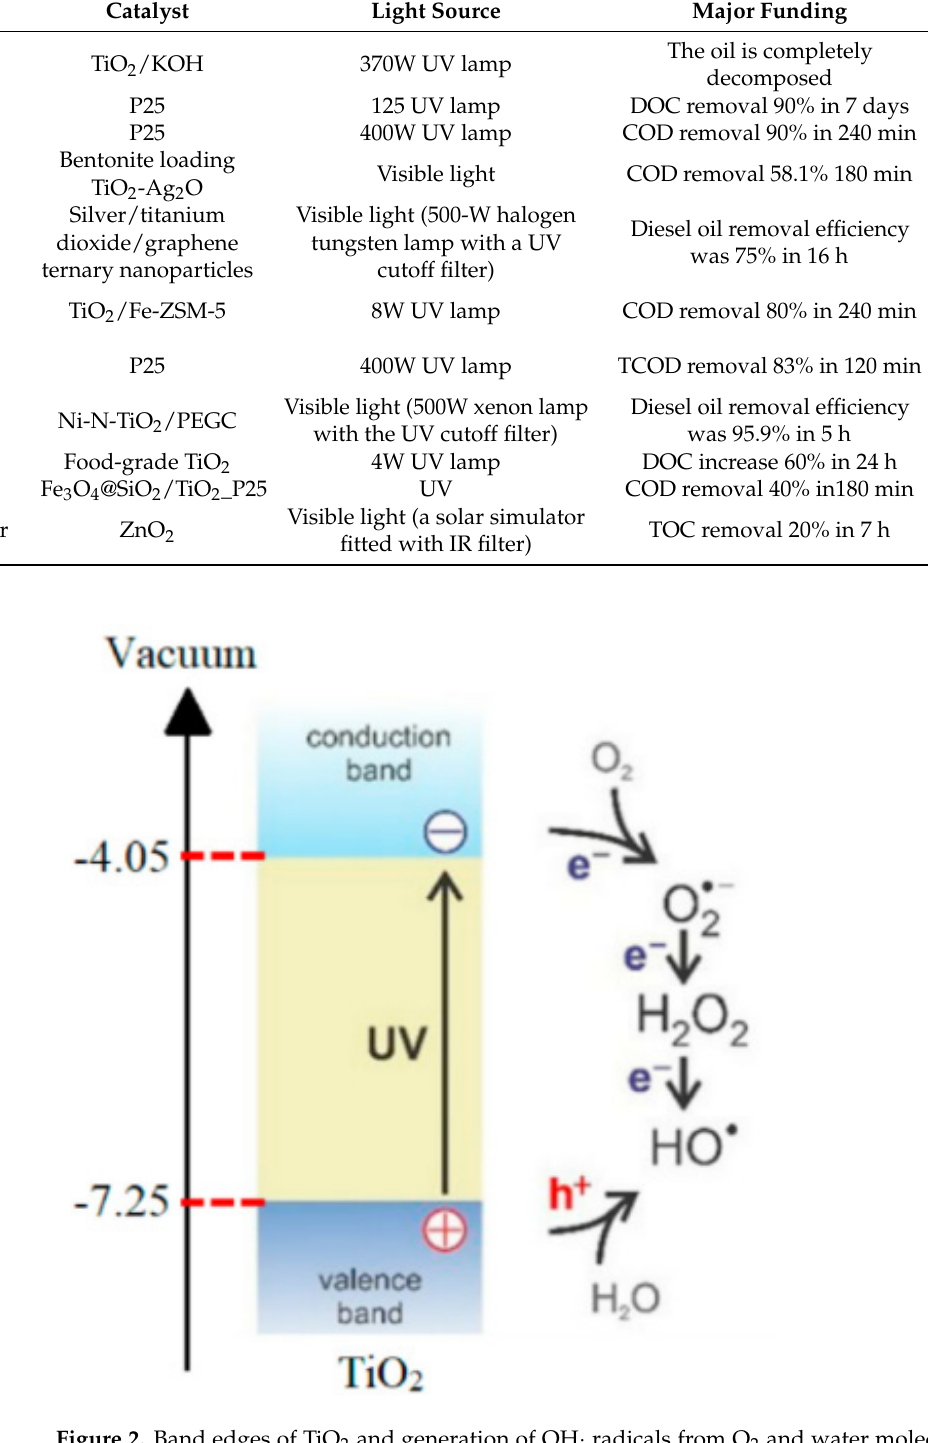
Figure 2. Band edges of TiO 2 and generation of OH· radicals from O 2 and water molecules upon UV-excitation [ 34 ]. Table 3. A summary of photocatalysis for different types of oil and gas wastewater.